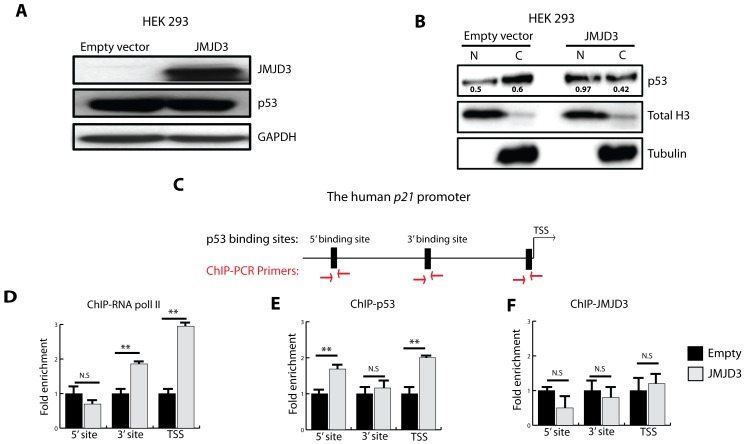

JMJD3 induction of p21 is p53-dependent.
A, Western blot analysis showing the effect of JMJD3 overexpression on total p53 levels in HEK 293 cells. B, Nuclear fractionation following JMJD3 overexpression in HEK 293 cells (N-Nuclear fraction, C-Cytoplasmic fraction). Total Histone 3 (Total H3) was used as nuclear loading control and Tubulin as cytoplasm loading control. Densitometry values of p53 expression (black) are relative to respective nuclear or cytoplasmic control. C, Schema of human p21 promoter showing p53 consensus binding sites and primers used for Chromatin immunoprecipitation with PCR (ChIP-PCR). TSS is transcription start site, 3′ and 5′ sites represent consensus p53 binding sites within the human p21 promoter. D–F, ChIP-PCR results showing localization of RNA polymerase II (D), p53 (E) and JMJD3 (F) at the p21 promoter in HEK 293 cells following JMJD3 overexpression. All experiments were done in triplicates. Error bars represent means ±SD. p = two-tailed Student’s t test comparing indicated samples to empty vector controls, *p<0.1, **p<0.05, ***p<0.01, N.S.- not significant.